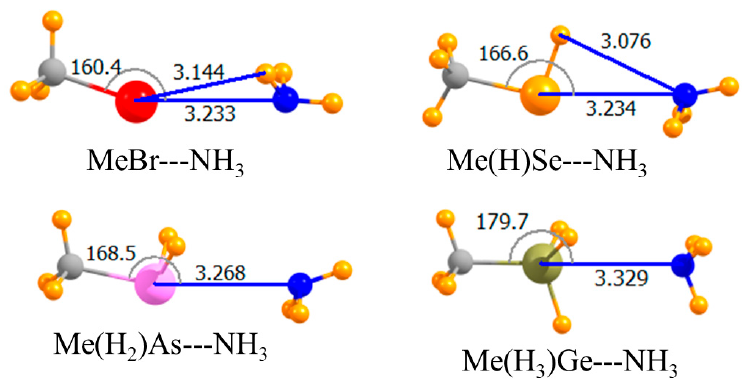
Figure 2. Optimized geometries of complexes of methyl Lewis acids with NH 3 . Intermolecular distances are in Å, angles in deg.